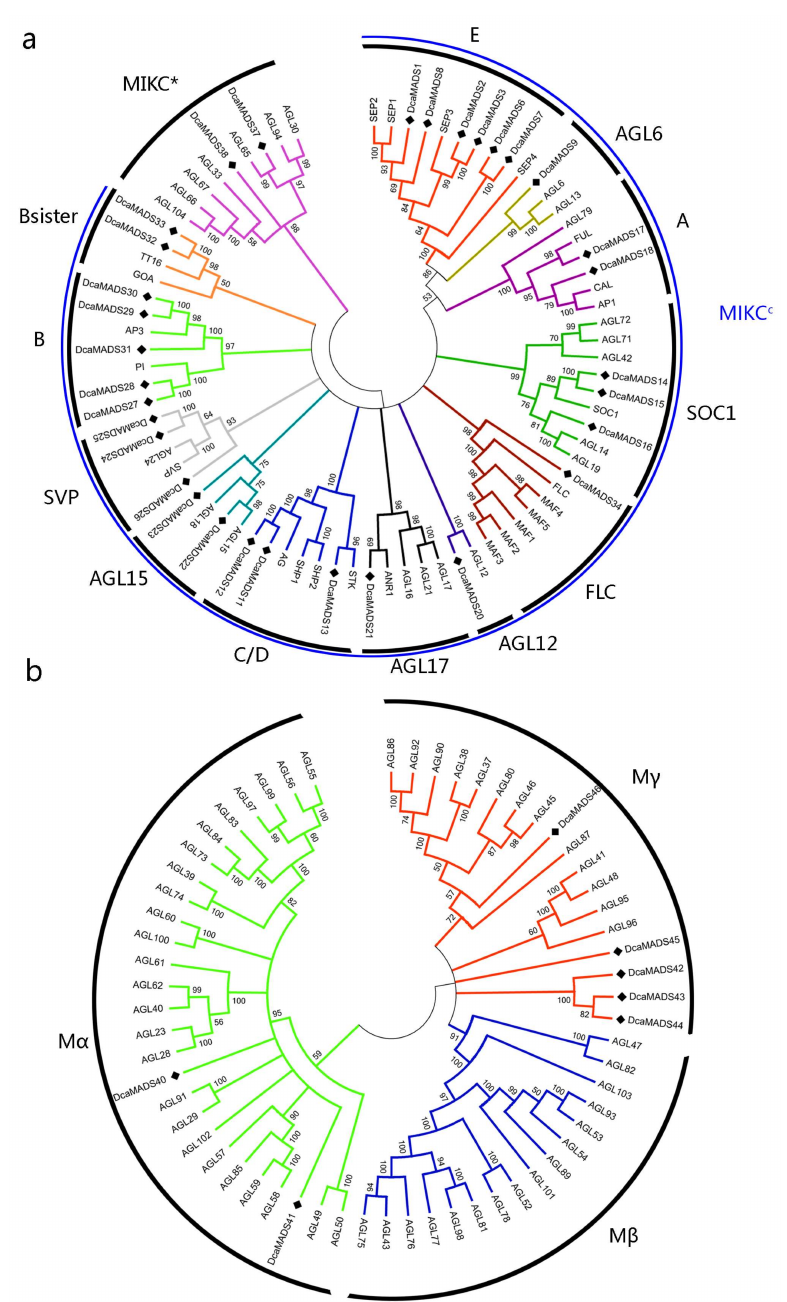
Figure 4. The phylogenetic tree of the 39 DcaMADS proteins was generated by the neighbour-joining (NJ) algorithm with 1000 iterations for the bootstrap values using Molecular Evolutionary Genetics Analysis (MEGA version 6.0) software [48]. The subgroups are marked in different colours. ( a ) Phylogenetic tree of Dianthus caryophyllus and Arabidopsis type II proteins. ( b ) Phylogenetic tree of Arabidopsis and D. caryophyllus type I